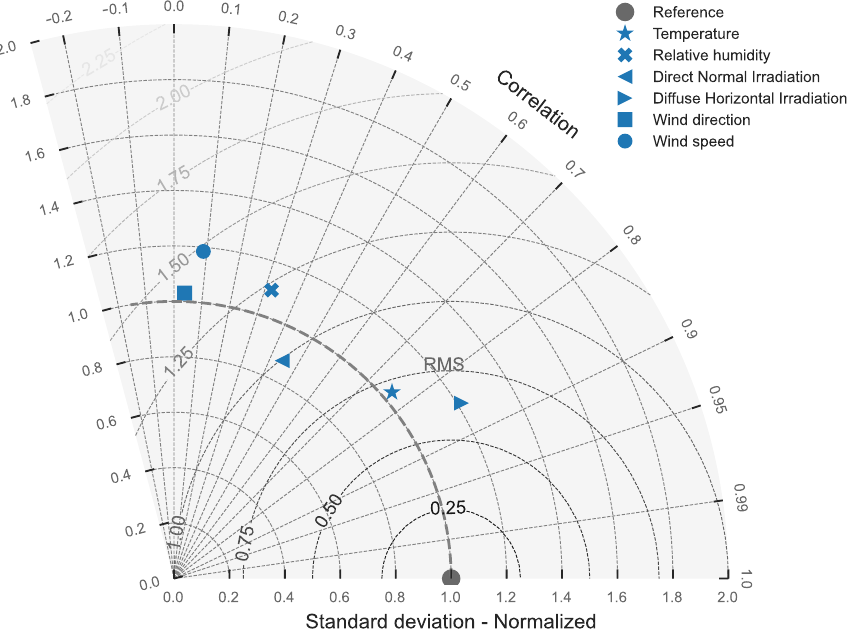
Figure 6. The normalized Taylor diagram for Holzkirchen (Germany) weather, comparing on-site and third-party weather